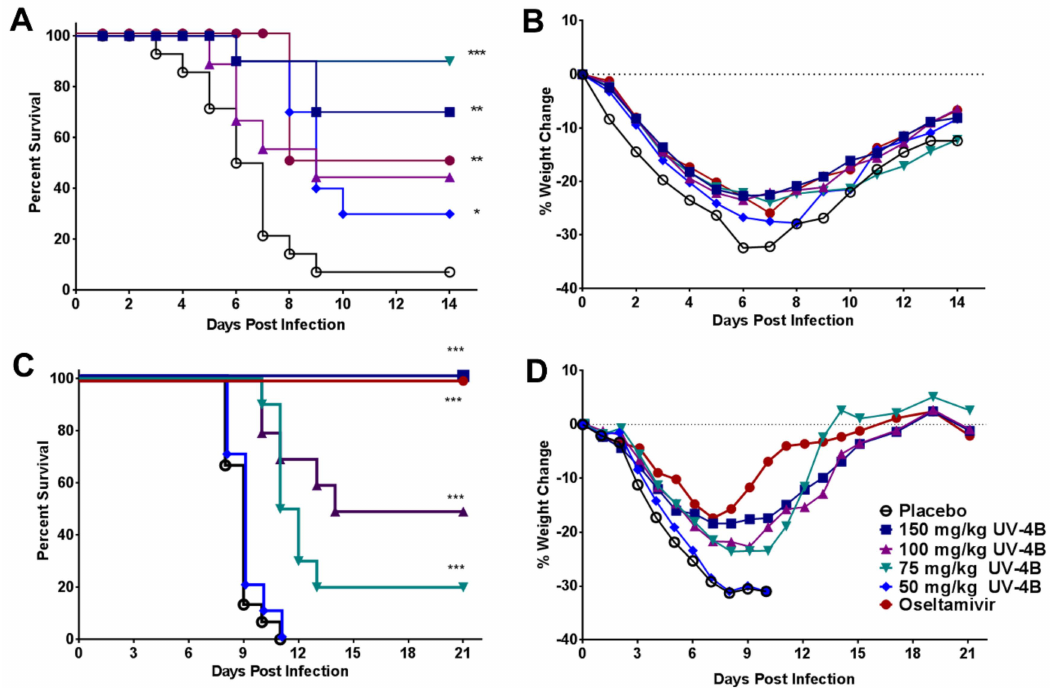
Figure 4. Antiviral efficacy of UV-4B in lethal mouse models of influenza A (H3N2) and B virus infections. Female BALB/c mice ( n = 10/group) were infected with ~1LD 90 of influenza virus via intranasal instillation. Mice were administered UV-4B diluted in sterile water. The dose levels are expressed as the active free base form, UV-4. Mice were orally treated with 50, 75, 100 or 150 mg/kg/dose of UV-4, vehicle or oseltamivir starting one hour before infection. Efficacy data are plotted as percent survival against days post virus exposure. Average weight changes/group are plotted versus days post virus exposure. ( A , B ) UV-4 efficacy following infection with influenza A/PA/10/2010 (H3N2) swine virus. In this study, UV-4 was administered for 7 days and oseltamivir was administered at 20 mg/kg/dose BID for 5 days. Mice were monitored for through 14 days post infection. ( C , D ) UV-4 efficacy following infection with influenza B/Sichuan/279/99. In this study, UV-4 was administered for 10 days and oseltamivir was administered at 10 mg/kg/dose TID for 5 days. Mice were monitored for through 21 days post infection. * p < 0.01, ** p < 0.001, *** p <